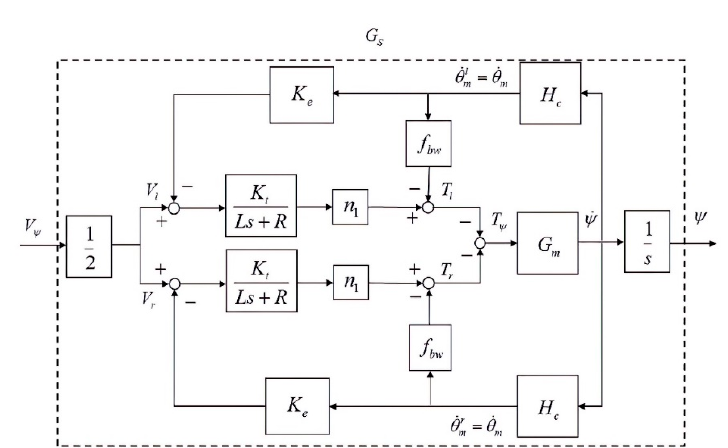
Figure 2. Block diagram of the TWIP